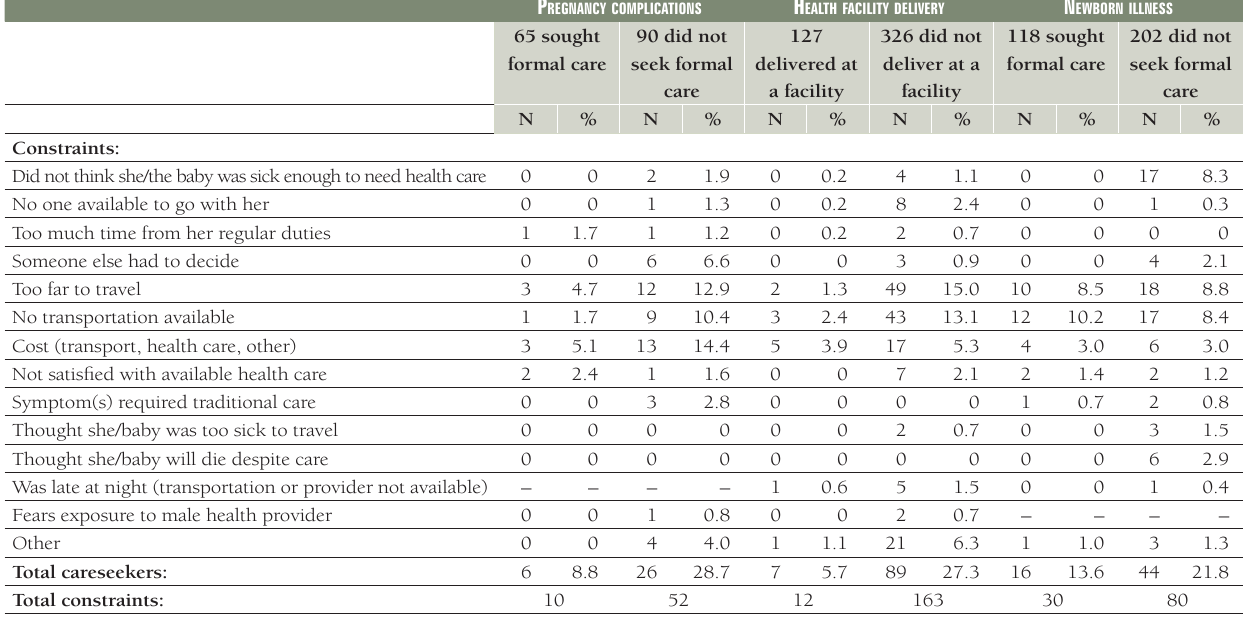
Table 4. Constraints for formal health careseeking for three situations contributing to neonatal deaths, 2007–2010,